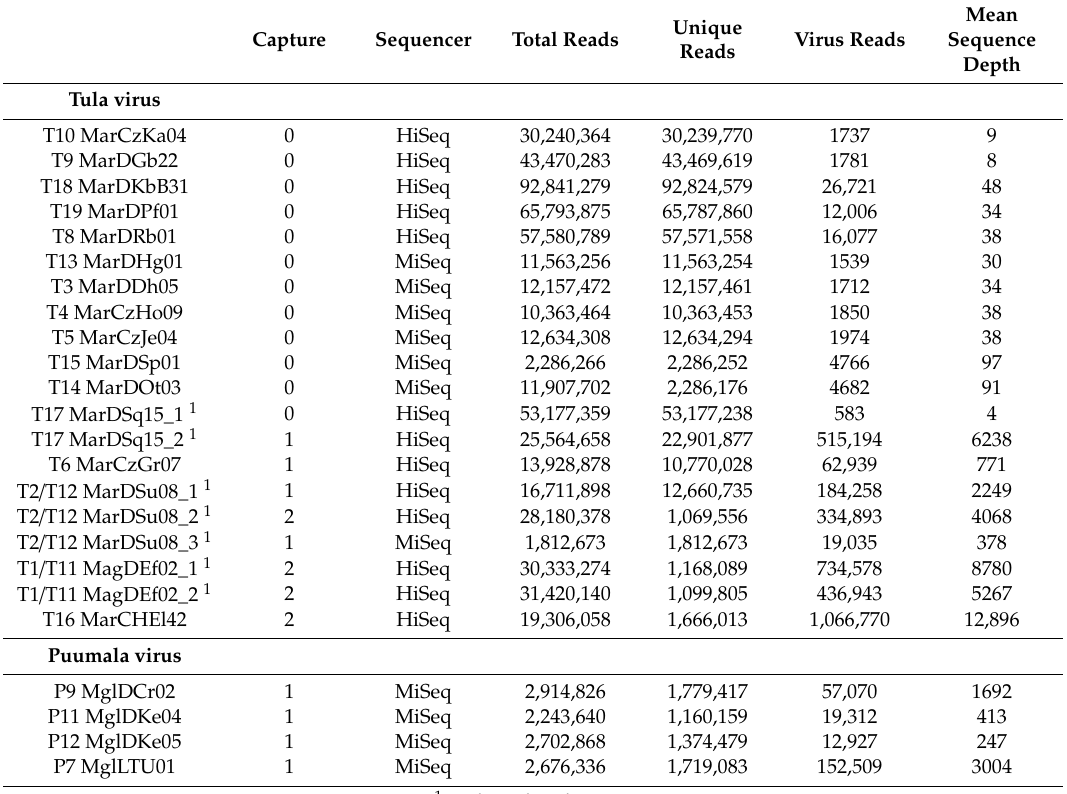
Table 1. List of TULV and PUUV high-throughput sequencing-based genome assemblies analyzed in this study. The number of capture rounds (zero: shotgun; one or two enrichment steps), the sequencing instrument used, number of total sequence reads, unique sequence reads (number of reads after filtering duplicates), mapped virus reads (deduplicated reads post-mapping) and the average genome sequence depth are shown. Shotgun sequence read data are from